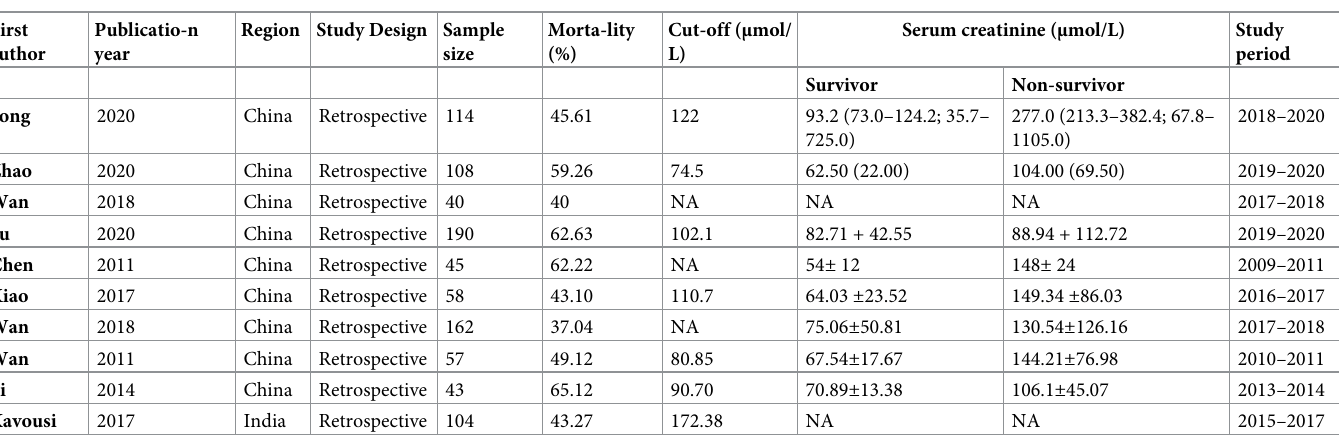
Table 1. Characteristics of included